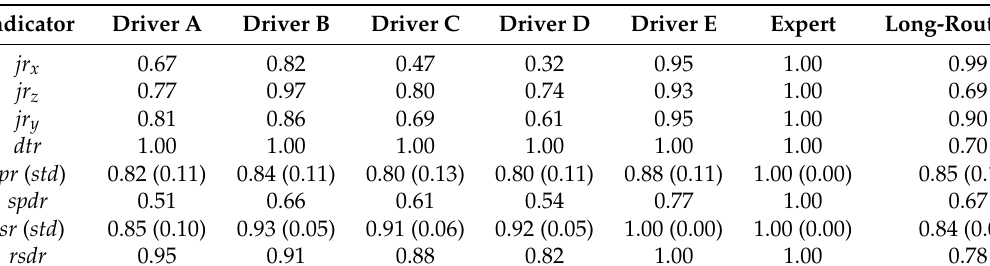
Table 3. Indicator values for the test rides.